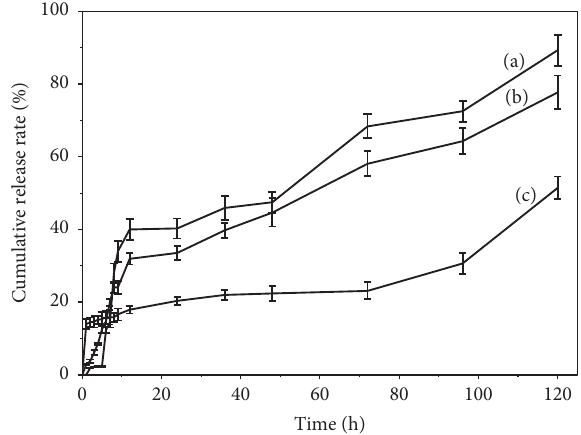
Figure 7: Relationship of the percent of cumulative release and time. (a) The weight ratio of SA and CS of 2:1 in the buffer so- lutions at a pH of 7.4; (b) the weight ratio of SA and CS of 5:1 in the buffer solutions at a pH of 7.4; (c) ghe weight ratio of SA and CS of 2 :1 in the buffer solutions at a pH of